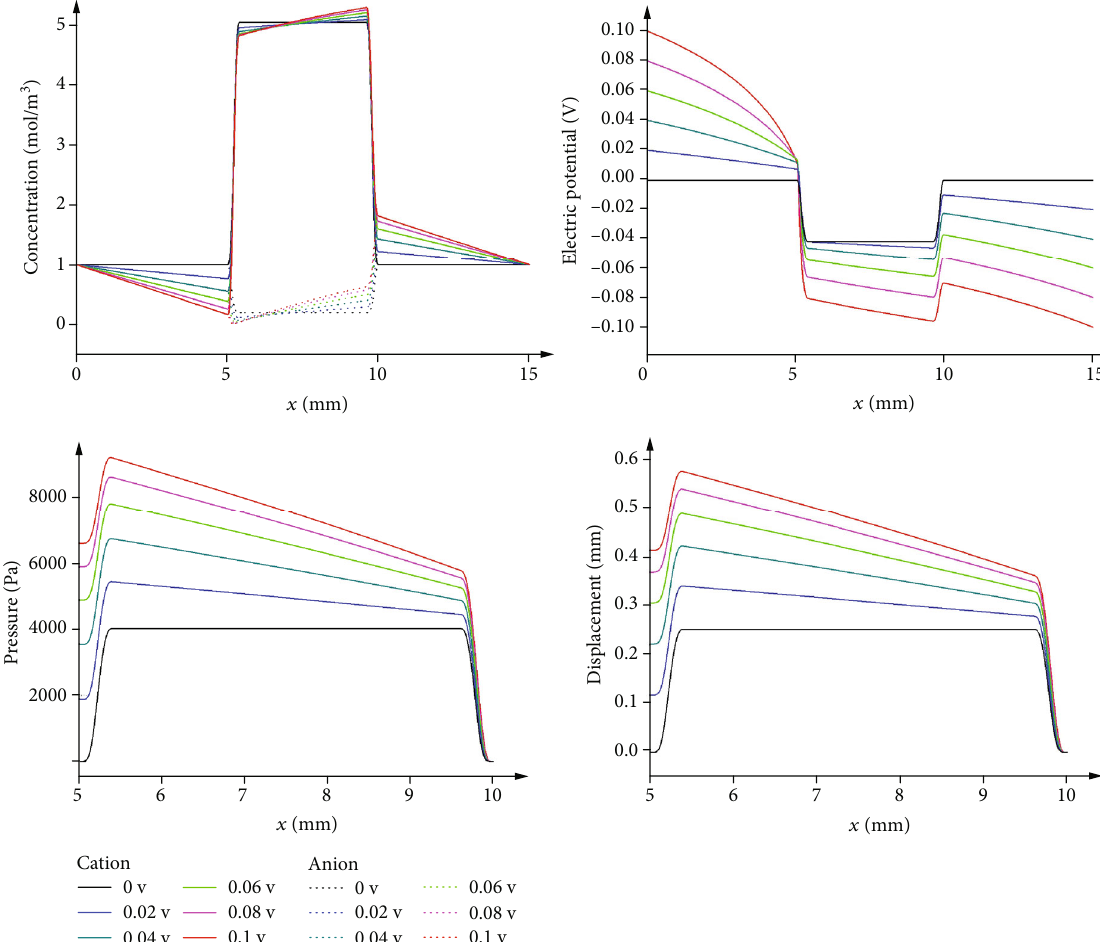
Figure 3: The distribution of free ion concentration, electric potential, fl uid pressure, and displacement under di ff erent external electric fi